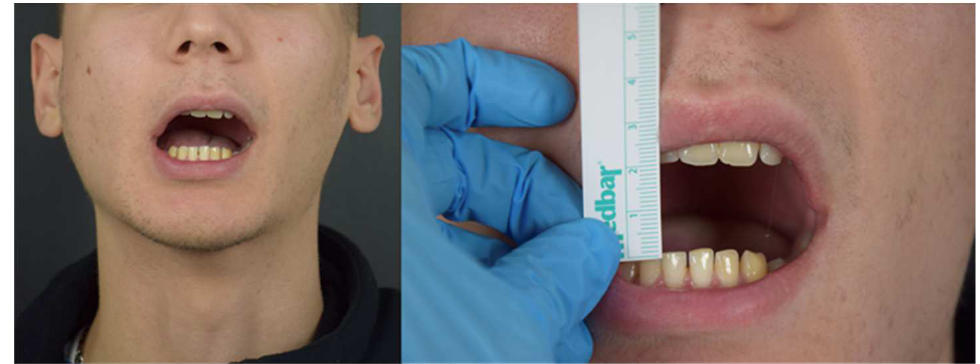
Figure 5. Patient showing an MMO of 20 mm and a slight deviation to the right at first physical examination.